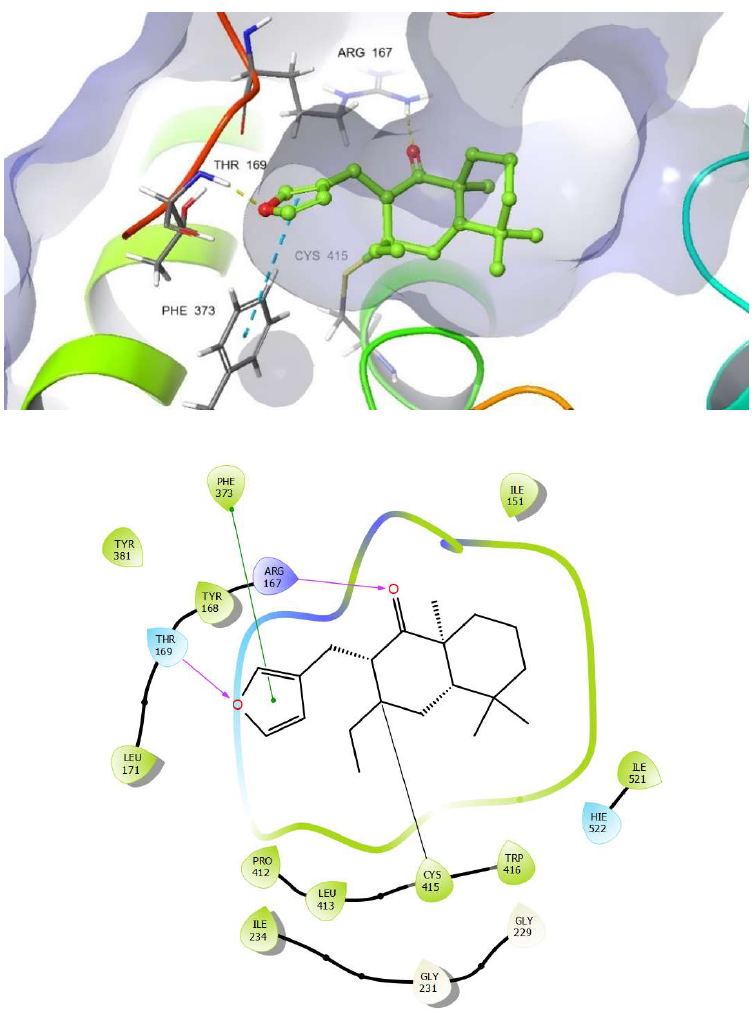
Figure 9. Covalent docking of DIH into the ADP binding site (PDB 7ALV) and its key